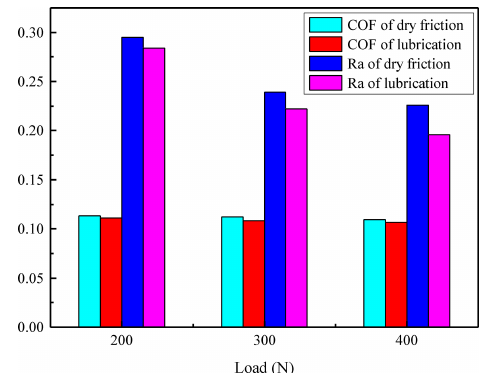
Figure 7. The COF of the cylinder liner under boundary lubrication conditions.